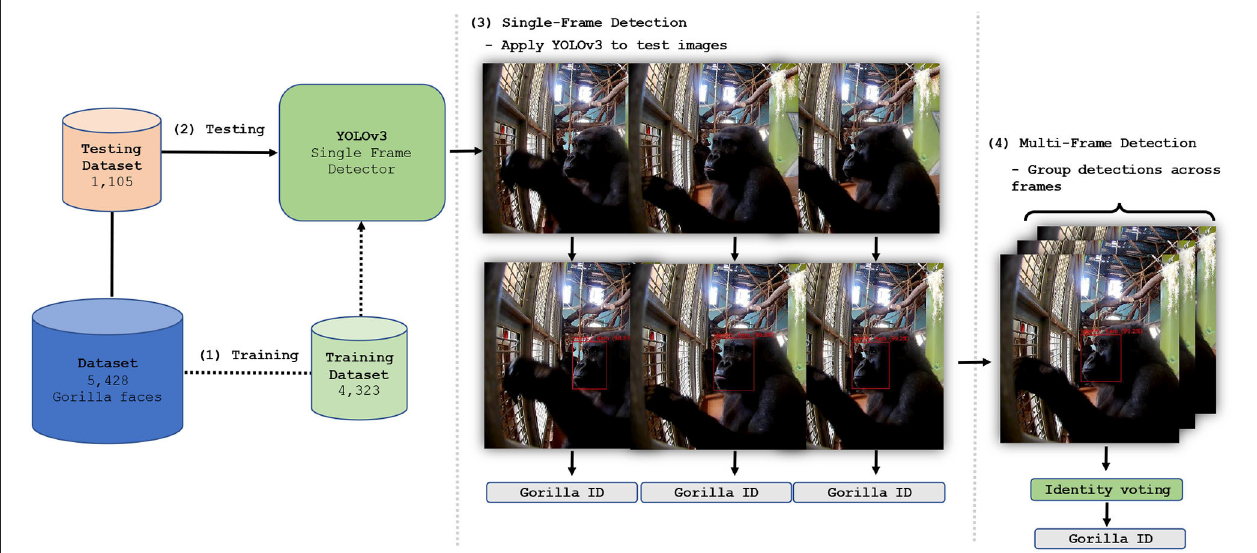
FIGURE 4 | Facial recognition model implementation and training. The dataset was used to train (1) and test (2) a YOLOv3 detection and classification system. The system was tested as a single frame recognition system (3), and a multi-frame system, (4) yielding facial location predictions and gorilla